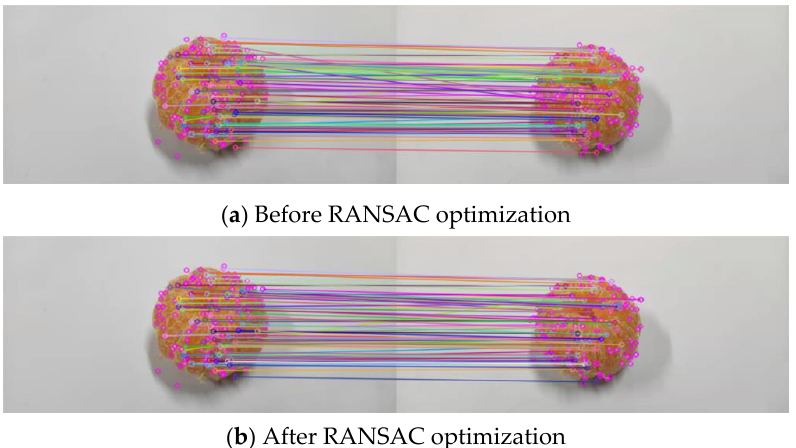
Figure 10. ( a , b ) is the supplementary experimental diagram of feature matching before and after RANSAC optimization.